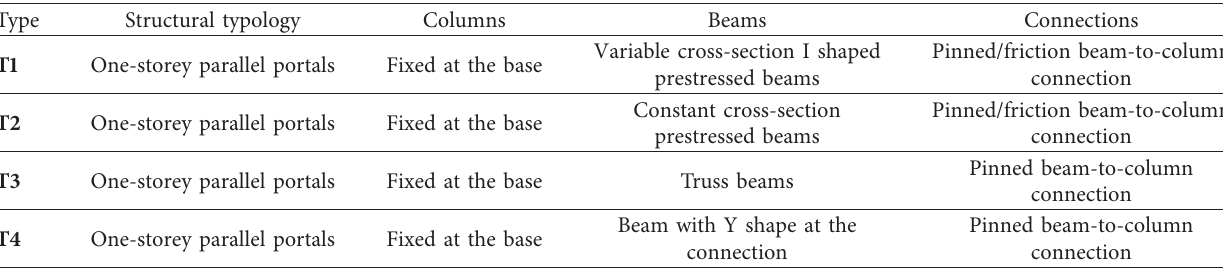
Figure 8: Description of the main RC precast typologies identified in Portugal: (a) variable cross-section I shaped prestressed beams; (b) constant cross-section prestressed beams; (c) truss beams; (d) beam with Y shape at the connection. Table 2: Precast industrial buildings typologies